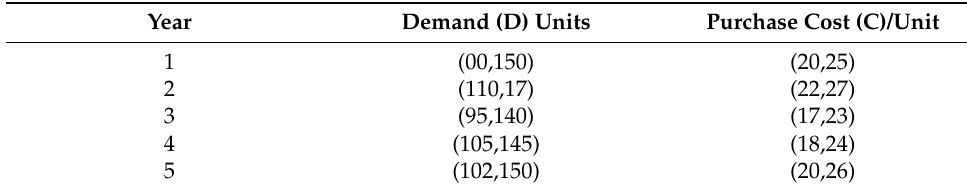
Table 1. Data of Demand and Purchase cost of 5